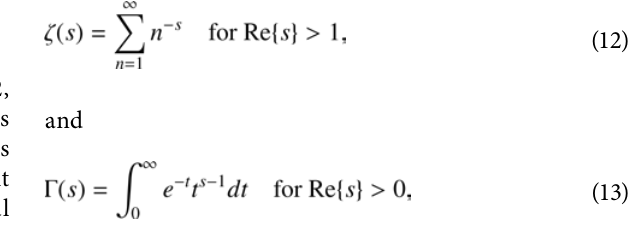
Figure 1. The series (5) interpolates between a uniformly flat profile (ε → ∞), a continuous wave (finite ε) and a train of particles (ε → 0). We illustrate this with the cases ε = 1/16 (highest peaks), 1/4, 1 and 4 (nearly